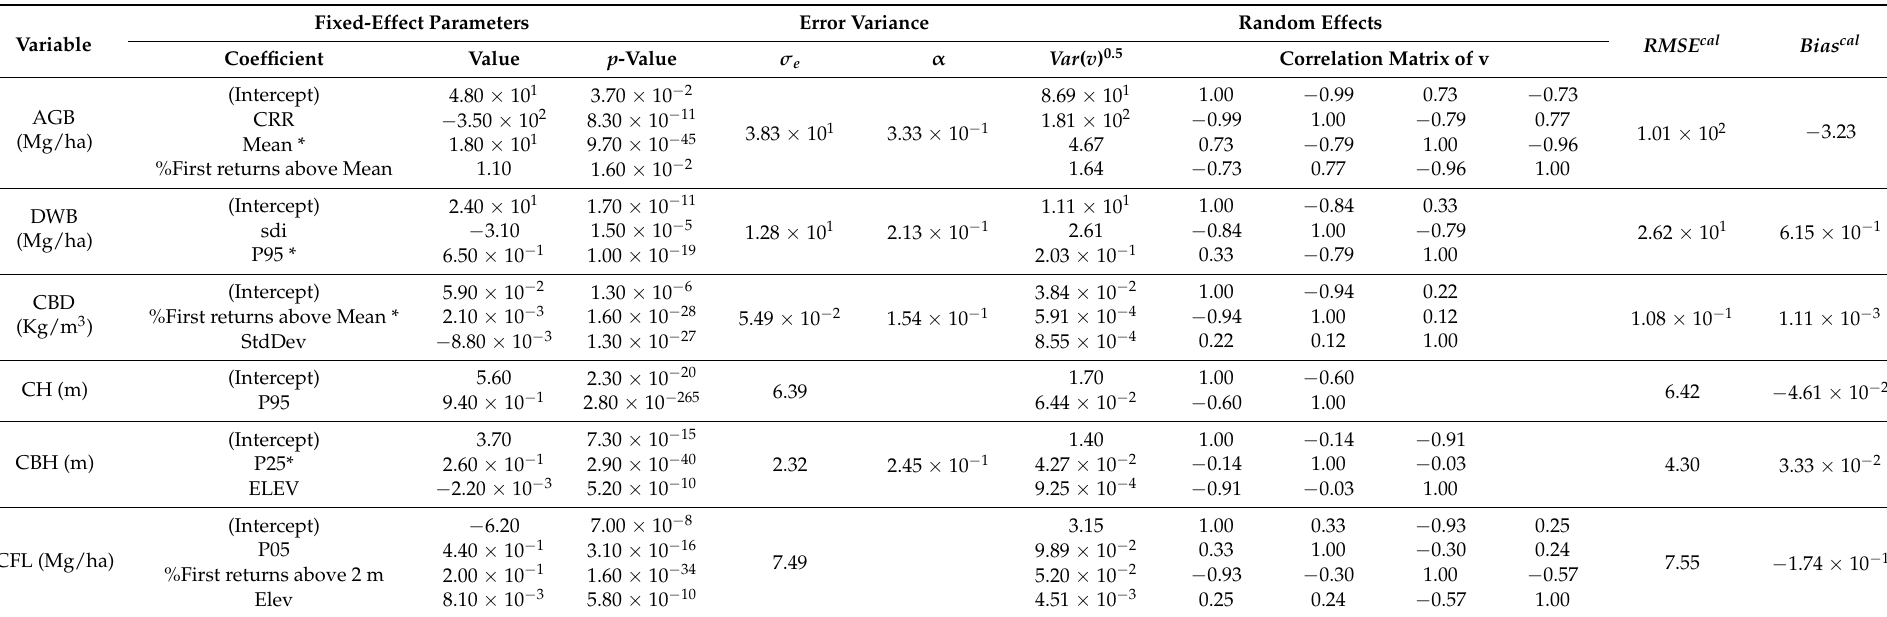
Table A6. Parameters and global performance metrics of linear mixed-effects models using rasterized predictors on extended set of 20 ALS data acquisitions with rasterized metrics described in Appendix A. * Indicates the most correlated predictor used to model heteroscedasticity. Model response variables are: aboveground biomass (AGB), downed woody biomass (DWB), canopy bulk density (CBD), canopy height (CH), canopy base height (CBH), and canopy fuel loading